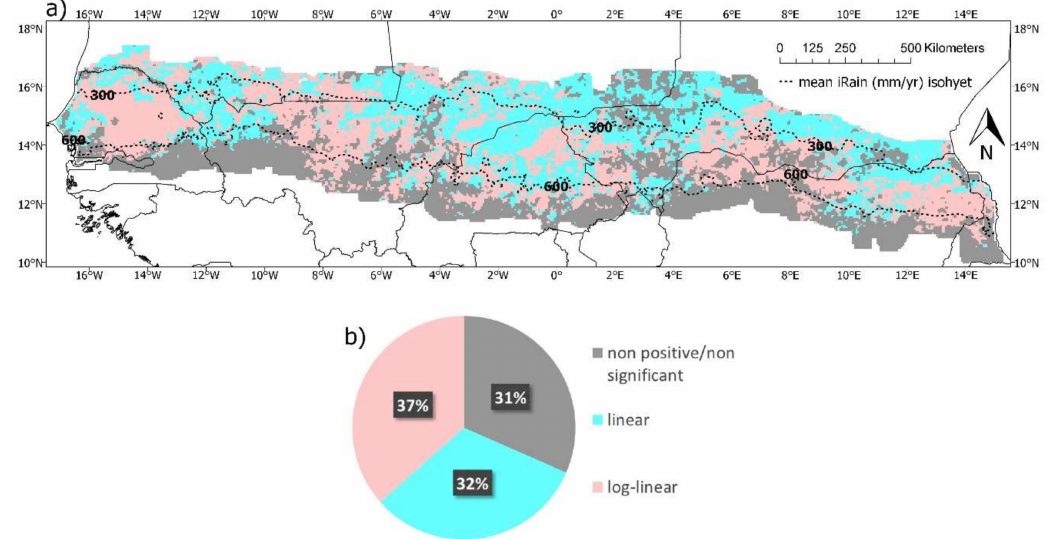
Figure 5. ( a ) Map showing “best” per-pixel i NDVI– i Rain relationship selected using Akaike Information Criterion (AIC) values of competing models. ( b ) Pie chart showing distribution of pixels according to the selected model. Grey colored pixels are locations with fitted slopes not significantly different from zero ( p > 0.05) in either model (or in a few cases, locations with significant negative slopes). In these areas, assumptions of the rain use efficiency approach are not met with our data